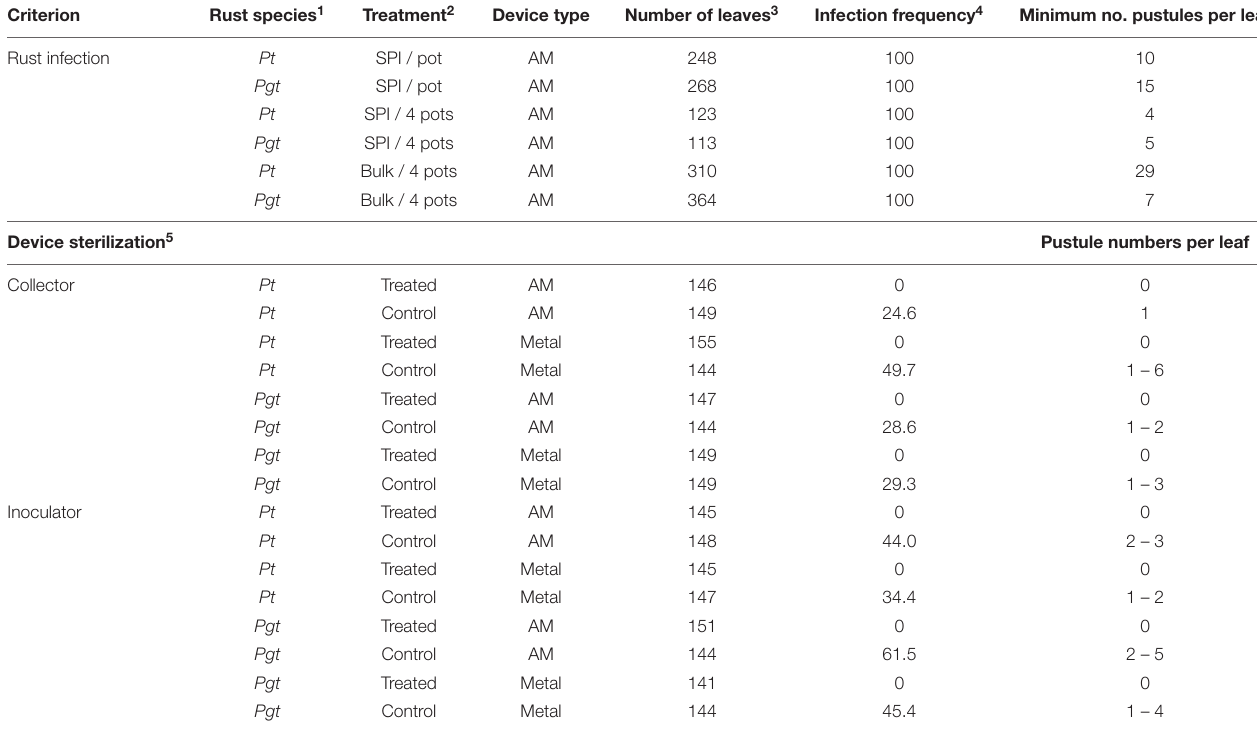
FIGURE 7 | Infection of a primary wheat leaf after inoculation of a differential set of 20 entries with a single pustule of P. graminis f. sp. tritici using an inoculator produced with AM.